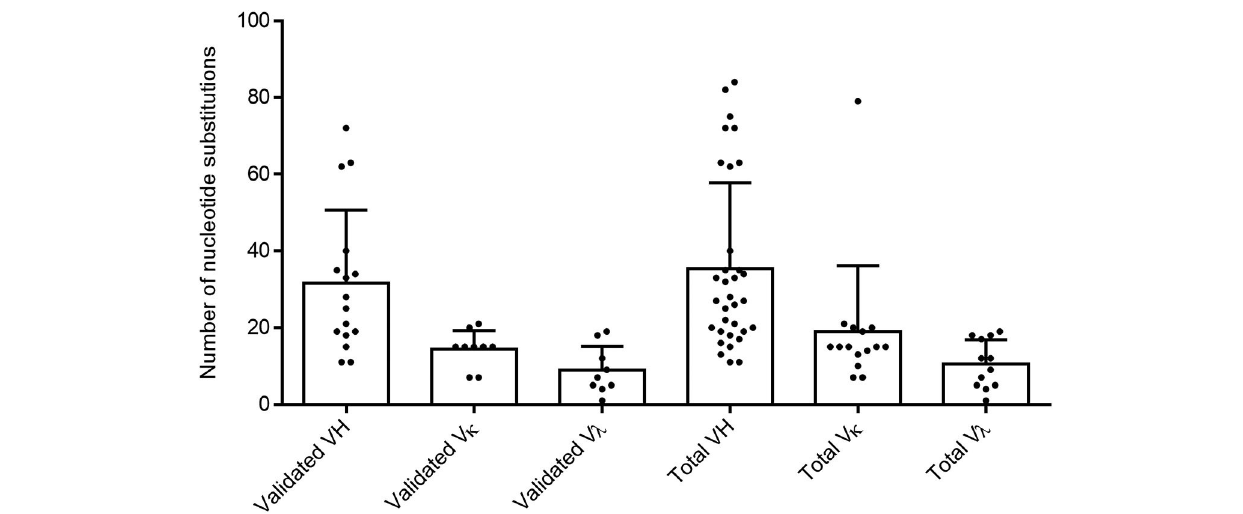
FIGURE 2 | Evaluating total nucleotide mutations in AAV memory B-cell variable region sequences. Average total nucleotide substitutions from the most likely germline allele (determined by IMGT) were quantified for variable heavy (H), variable kappa ( κ ), and variable lambda ( λ ) chain sequences of anti-AAV mAbs confirmed to bind AAV in vitro (“validated”) or of all sequences isolated from cultures with AAV-reactive supernatant (“total”). Data are reported as mean +